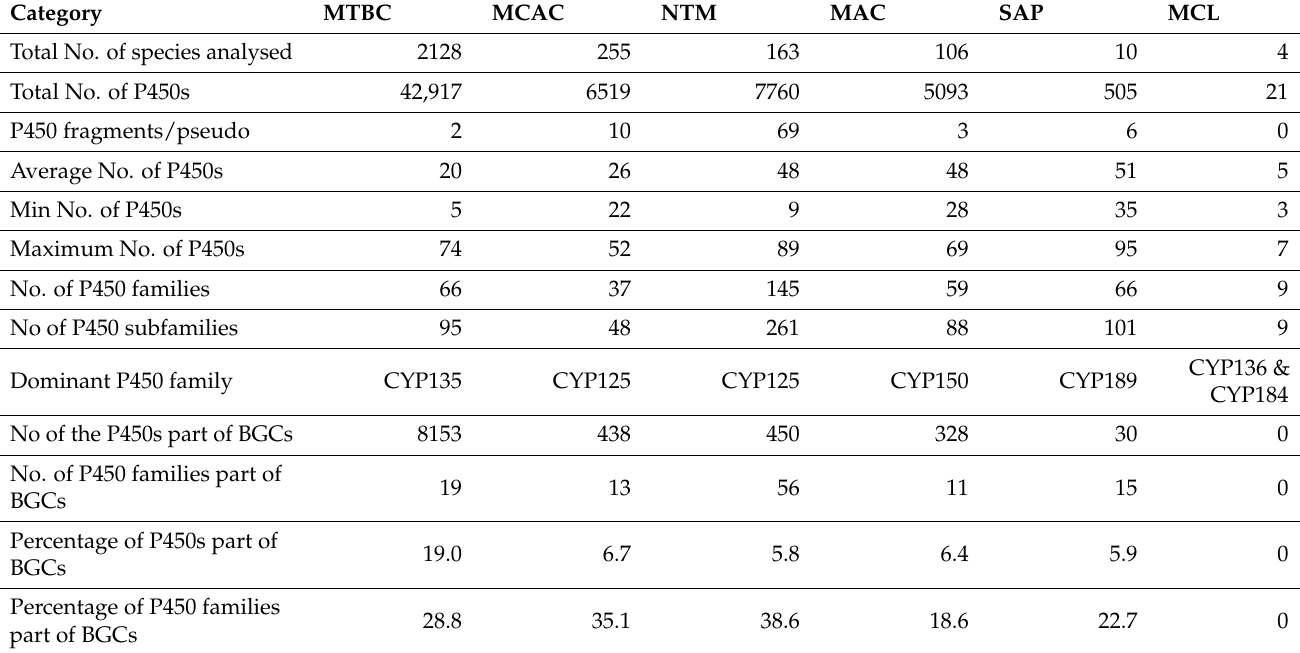
Table 2. Comparative analysis of key features of P450s and their association with secondary metabolism in mycobacterial categories. A statistical analysis of P450 counts among different my- cobacterial categories was presented in Table S2. Abbreviations: MTBC, Mycobacterium tuberculosis complex; MCAC, M. chelonae-abscessus complex; MAC, M. avium complex; MCL, Mycobacteria caus- ing leprosy; NTM, nontuberculous mycobacteria; and SAP, Saprophytes; No., number of; BGCs, biosynthetic gene clusters.